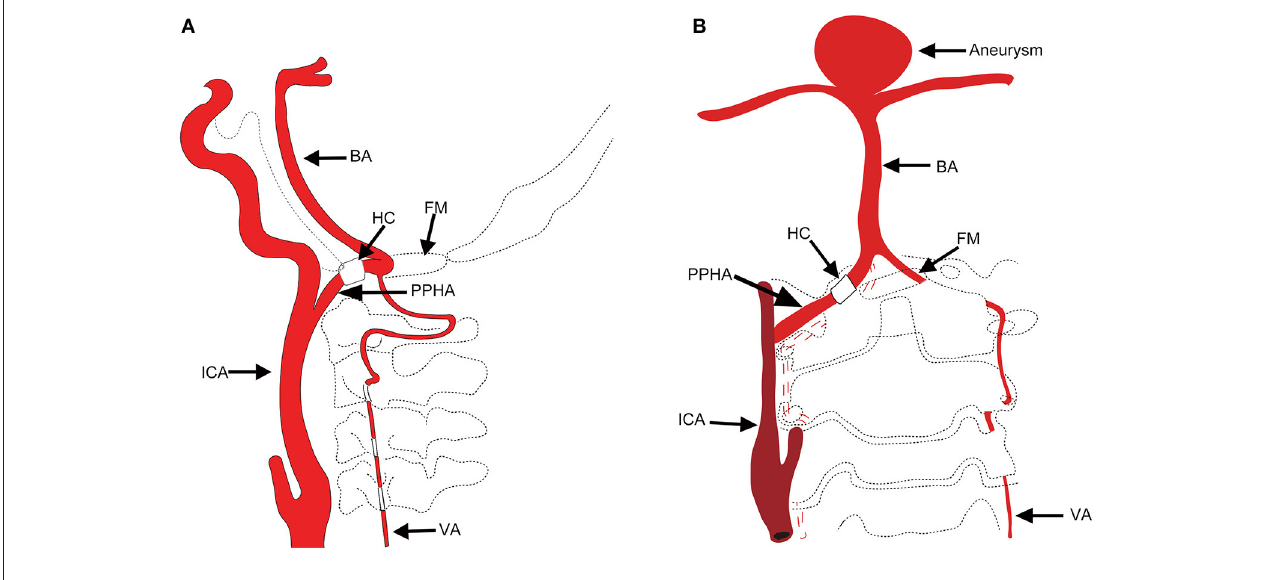
FIGURE 1 | (A) Schematic of the PPHA in our patient. BA, basilar artery; HC, hypoglossal canal; FM, foramen magnum; PPHA, persistent primitive hypoglossal artery; ICA, internal carotid artery; VA, vertebral artery. (B) The schematic of basilar bifurcation aneurysm.